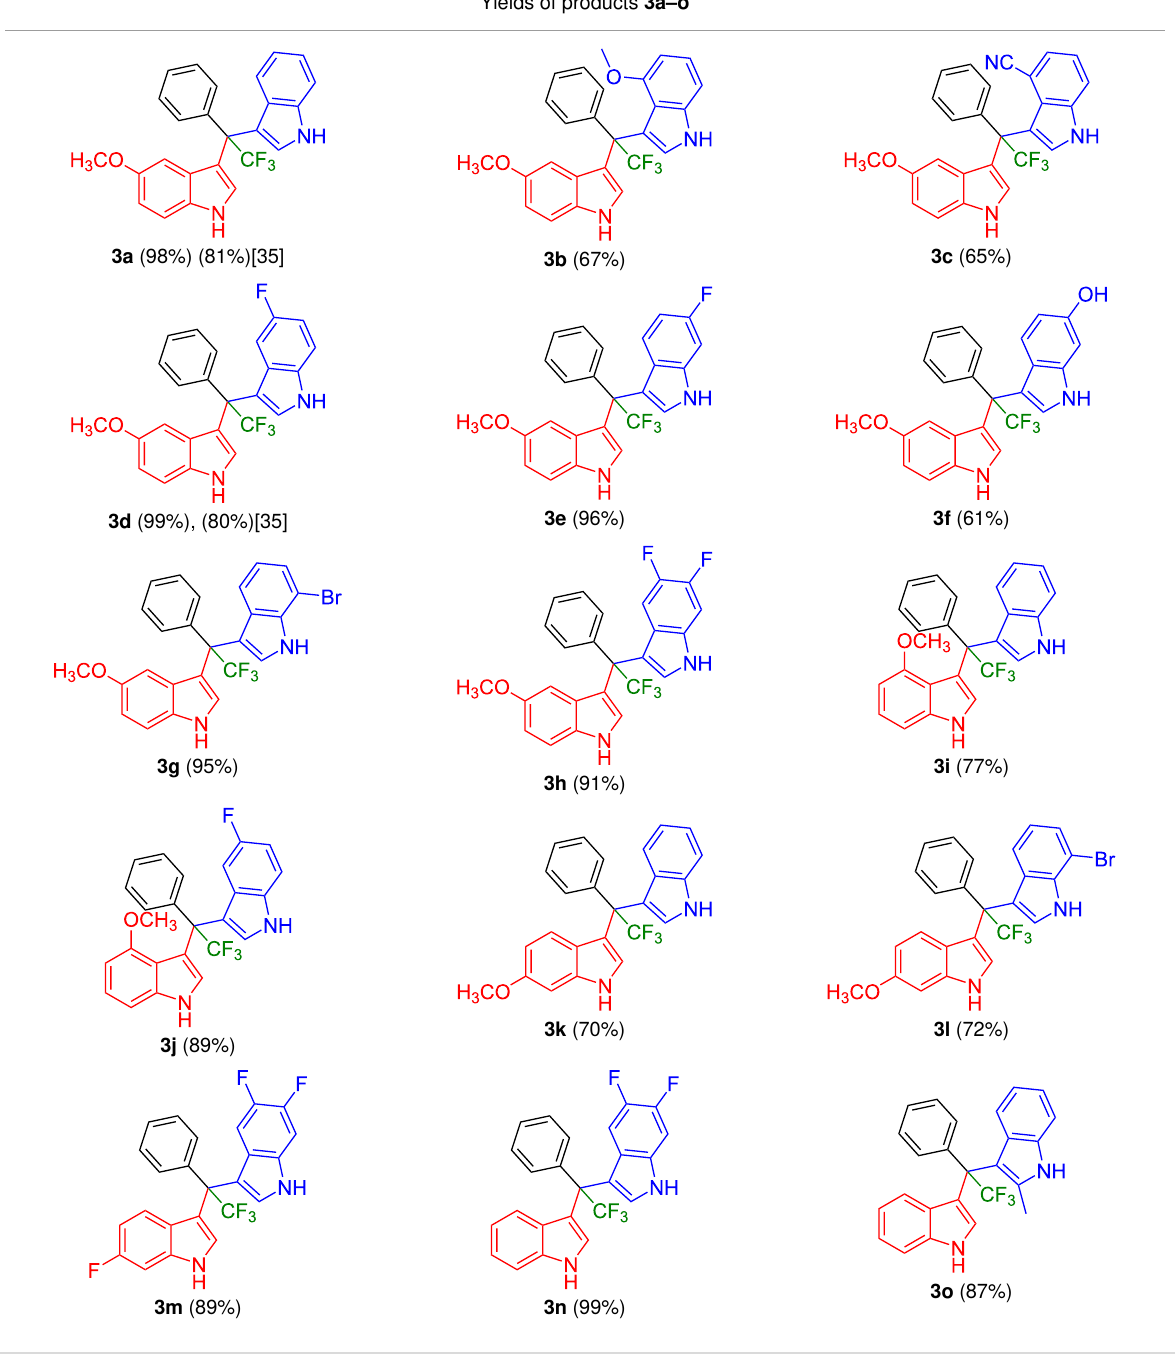
Table 2: Substrate scope of the reaction with differently substitute indole derivatives 2 . (continued) Yields of products